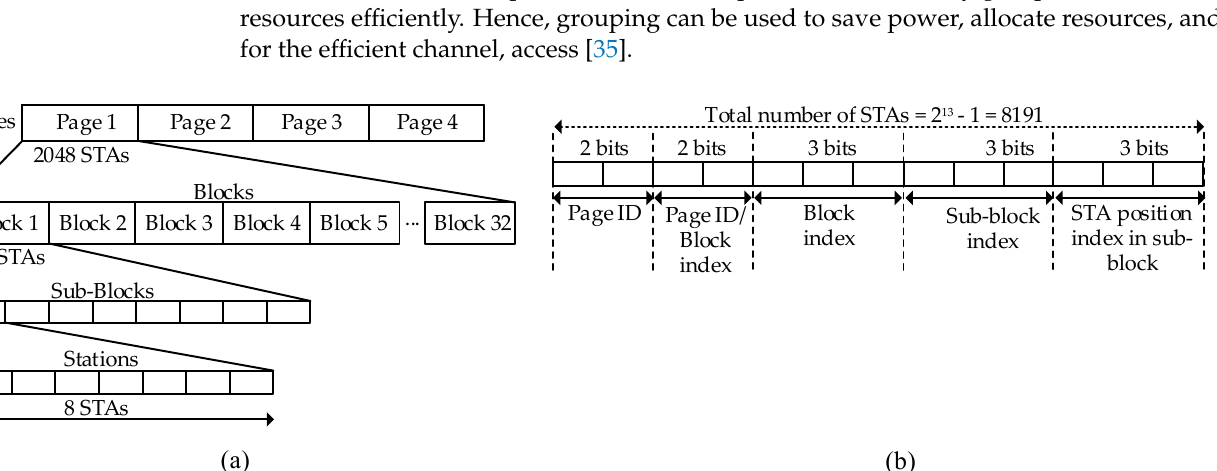
where PageID is the page identifier and SubBlockIndex , and BitPositionO f Station comprise three bits. Equation (2) shows the calculation of a unique number per STA based on the hierarchical structure illustrated in Figure 7b